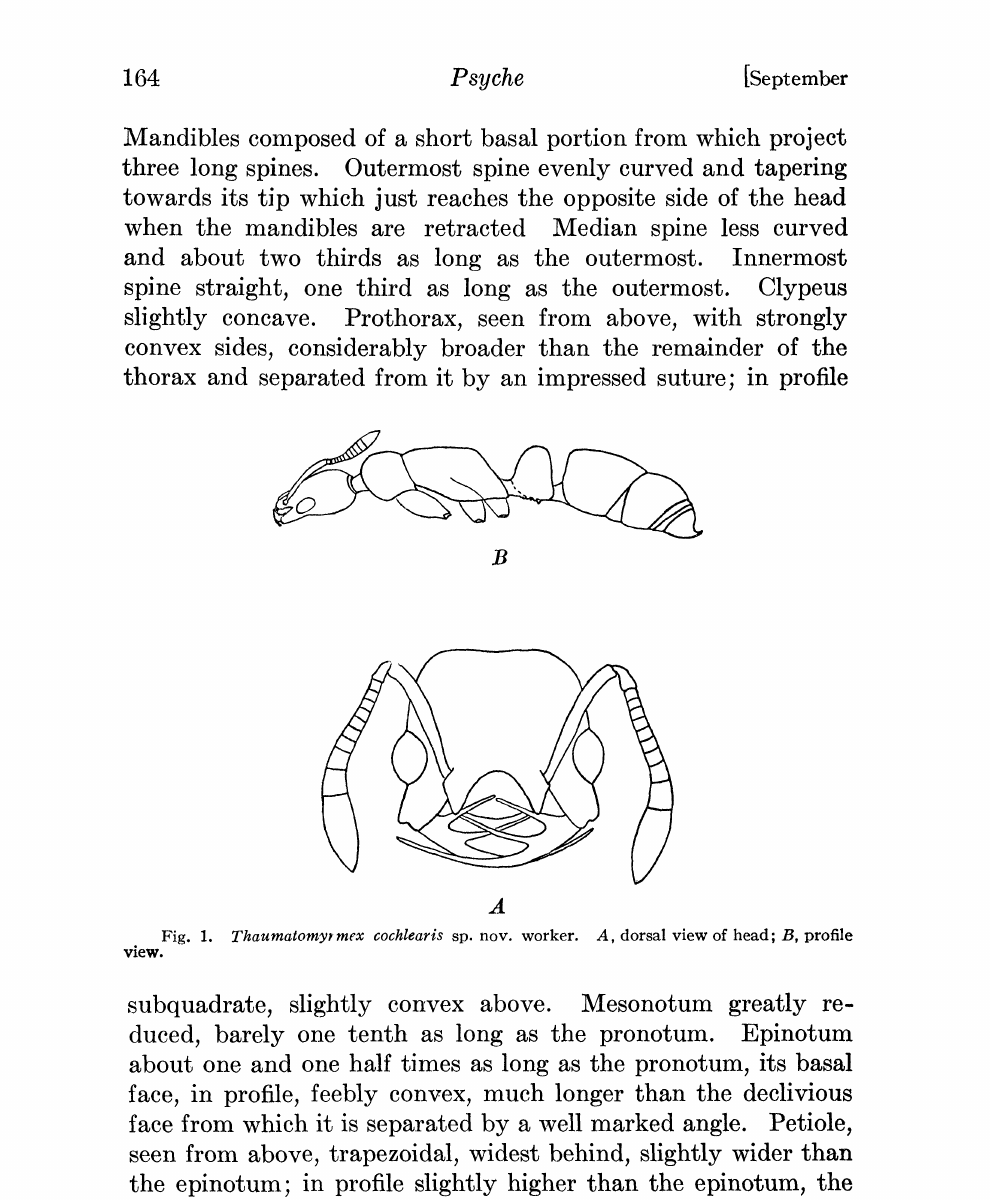
Thaumatomy, mex ochlearis sp. nov. worker. A, dorsal view of head; B, Fig. 1. view.